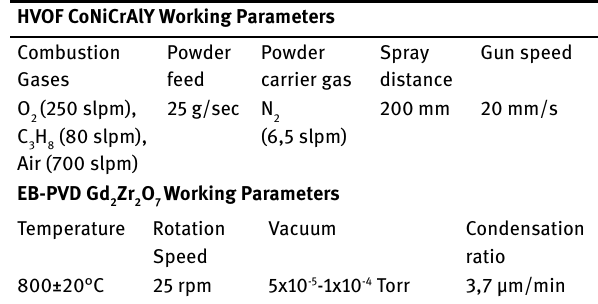
Table 1: Bond and top coating working parameters.